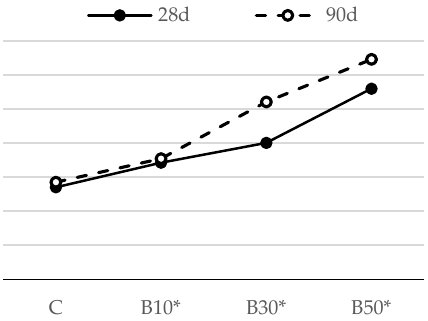
Figure 14. Flexural strength of mortars blended with biomass ash, with decreased w/b.